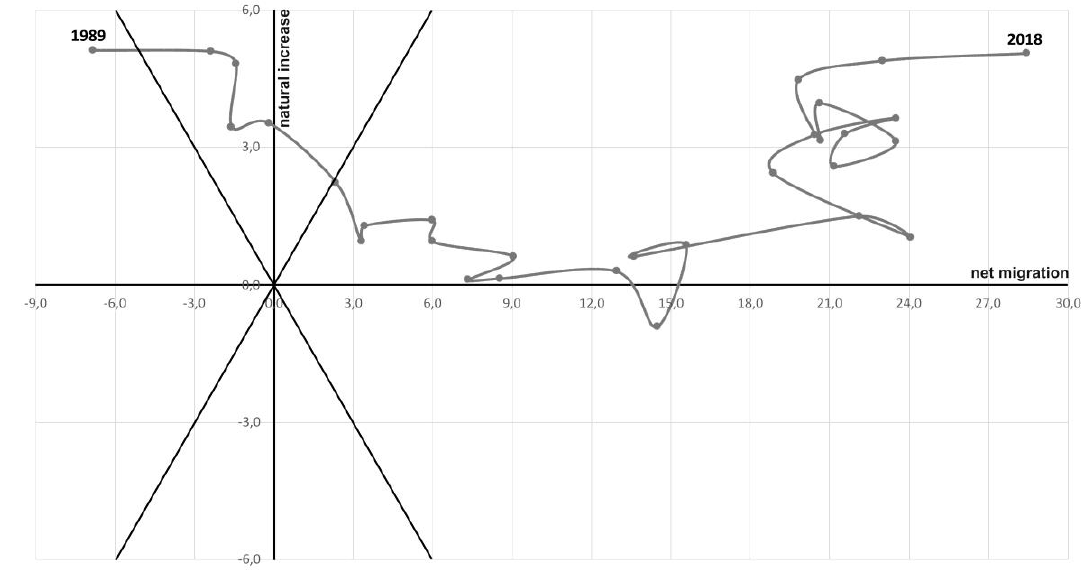
Fig. 5. Dynamic W EBB (1963) diagram for the suburban zone of Wrocław